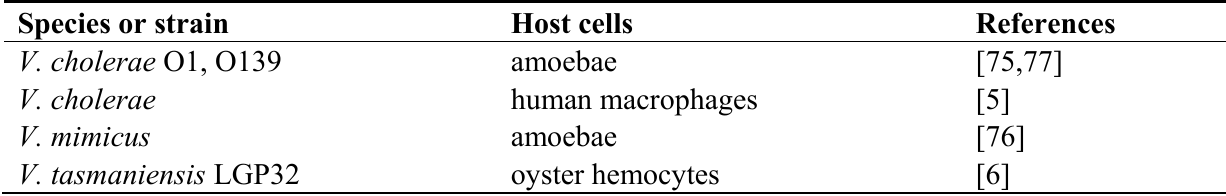
Table 3. Vibrios colonizing